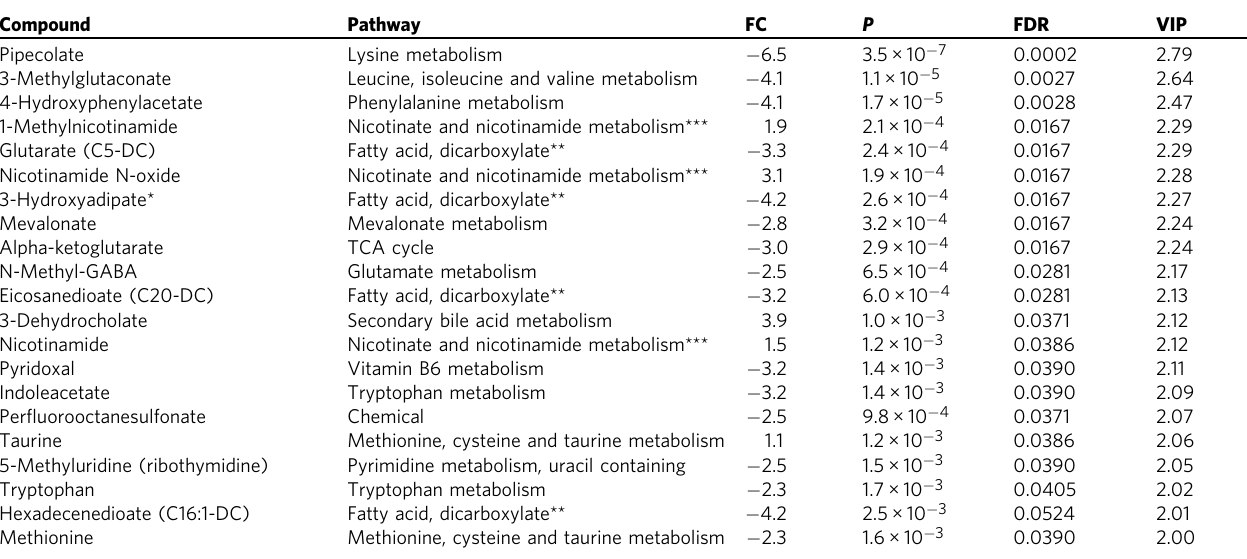
Table 2 Serum metabolomics of host – gut microbiota interactions in rats exposed to a pesticide mixture reveals alterations in multiple metabolic pathways.